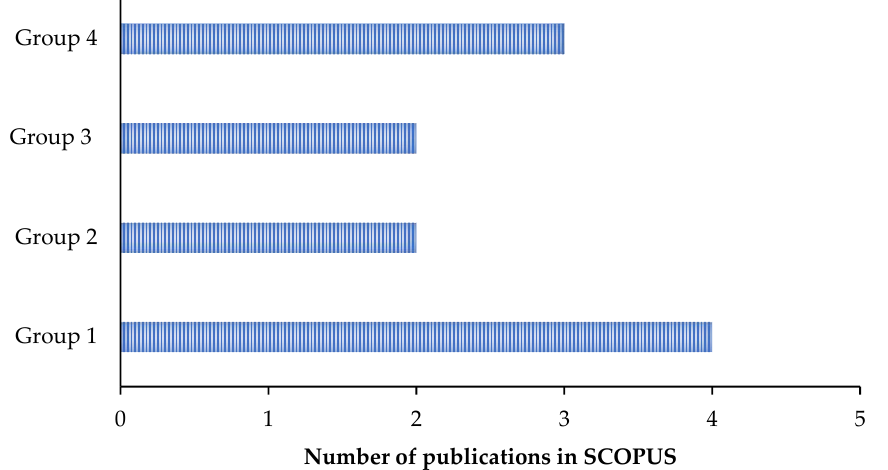
Figure 15. Distribution of publications in the SCOPUS database between four areas of corrosion measurement using optical fiber sensors.